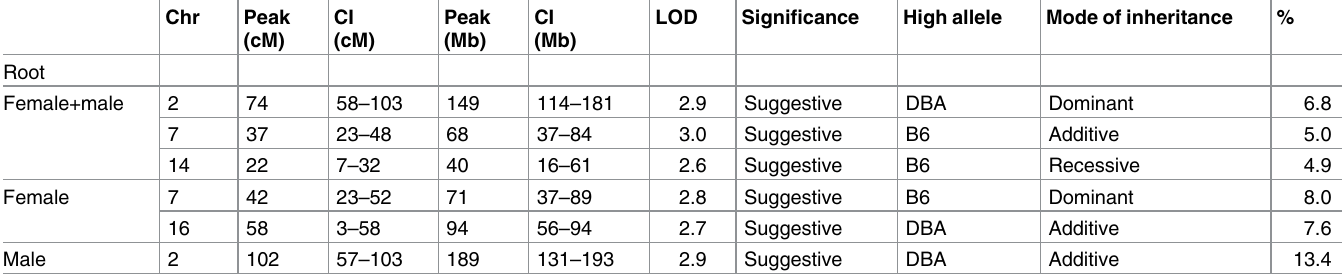
CI, 95% credible interval; LOD, logarithm of odds; LOD score for sex-combined scan shown in Table 4 was determined in single locus scan using sex as additive; the significance thresholds for LOD scores were determined by 1000 permutations using R/qtl software; for each QTL, model of inheritance was determined according to allelic effect at the nearest marker of a QTL by performing Haley-Knott regression using the additive and dominant/recessive models; % Variance indicates the percentage of the total F2 phenotypic